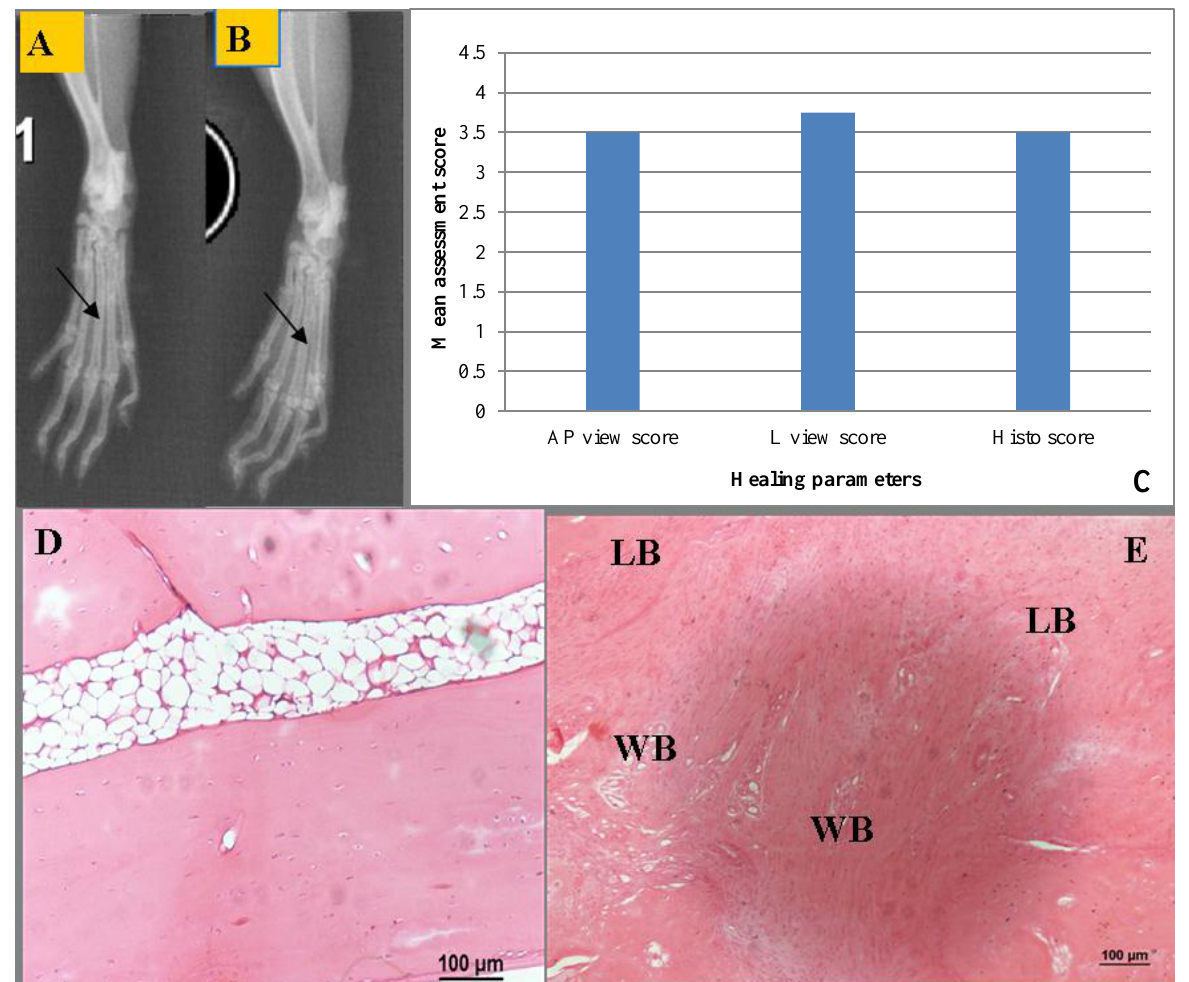
Figure 8. The radiographic, graphical and light micrographs of healing assessment at week 7 of fracture healing. (A and B) representative radiographic features of healing at week 7, arrows on the radiographs indicate point of fractures, (C) graphical presentation of radiographic AP, L views and histological healing scores showing no significant differences among the 3 healing scoring parameters. D and E are histological features of controlled and fractured bones respectively at week 7 of fracture healing showing cortical bridging of the fracture line with few woven bones (WB) mixed in the predominant lamella bones (LB). Scale bar =100 µm in all panels, X10 objective. Slides were stained with H and